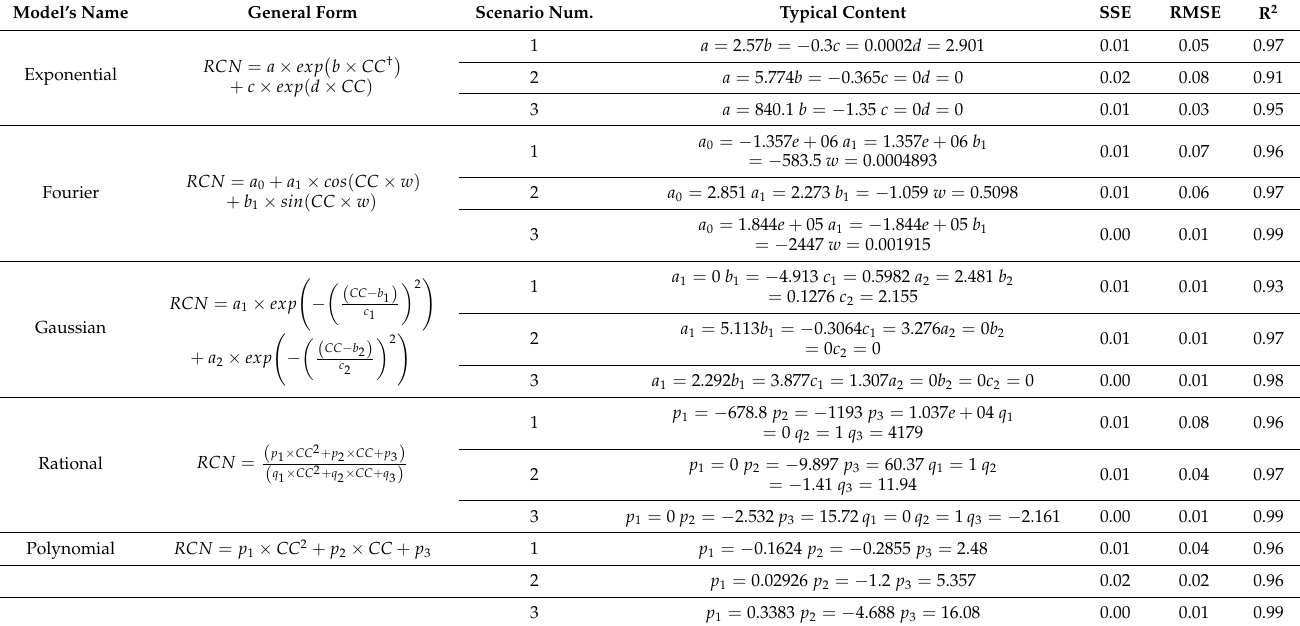
Table 3. Mathematical models for predicting residual cyanide based on the injected chlorine dose in different scenarios of contamination ((1) [CN − ] = 2.5 mg L − 1 , (2) [CN − ] = 5 mg L − 1 , (3) [CN − ] = 7.5 mg L − 1